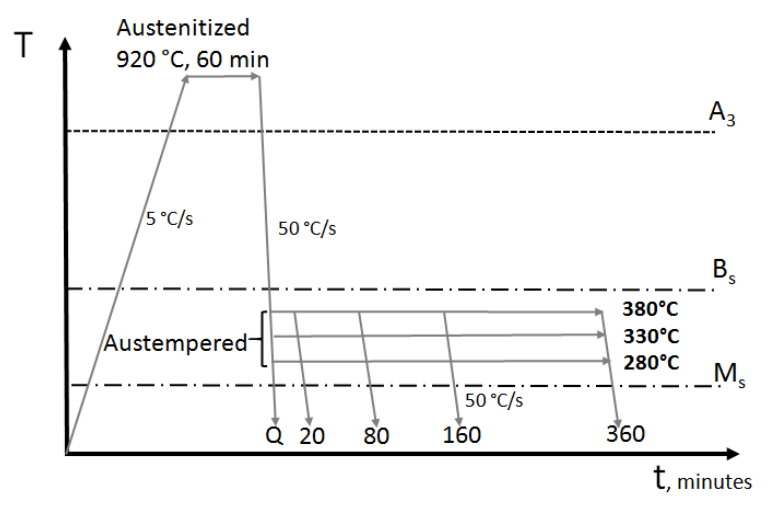
Figure 2. Schematic view of the heat treatments schedules (temperature vs. time) used in this